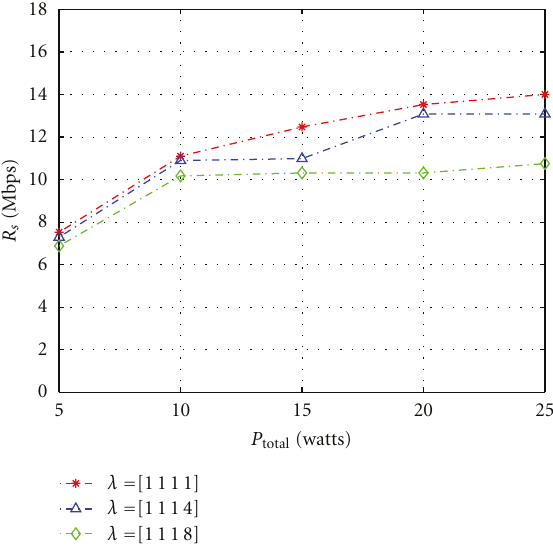
Figure 3: Average total CRU bit rate, R s , versus total CRU transmit power, P total , with I total = 0 . 02 W, P m = 5W, and λ = [1 1 1 8].